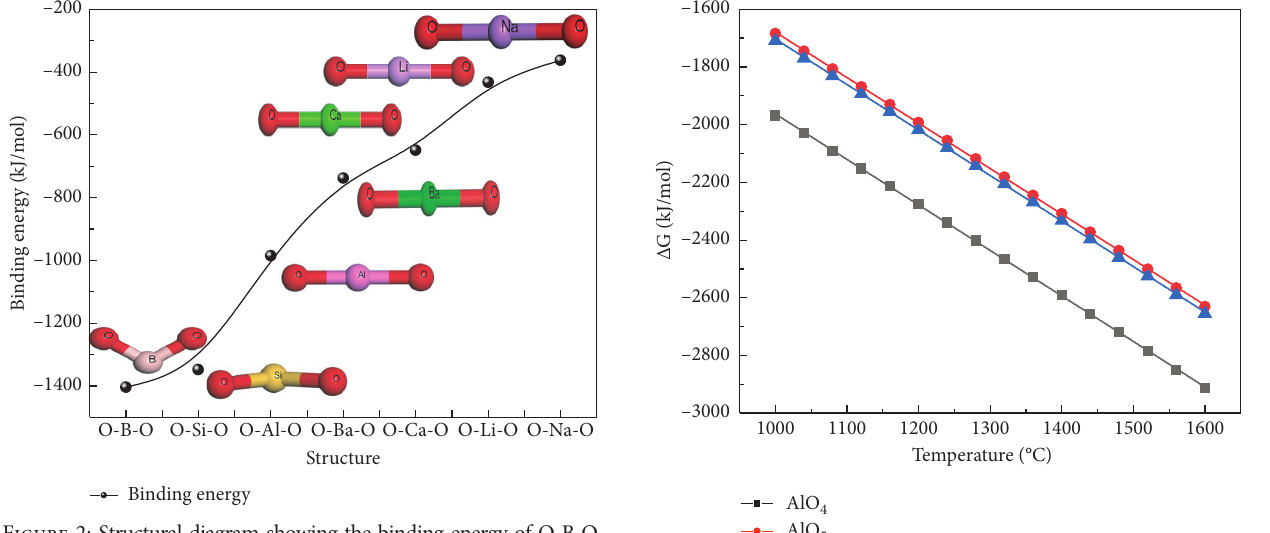
Figure 2: Structural diagram showing the binding energy of O-B-O, O-Si-O, O-Al-O, O-Ba-O, O-Ca-O, O-Li-O, and O-Na-O.